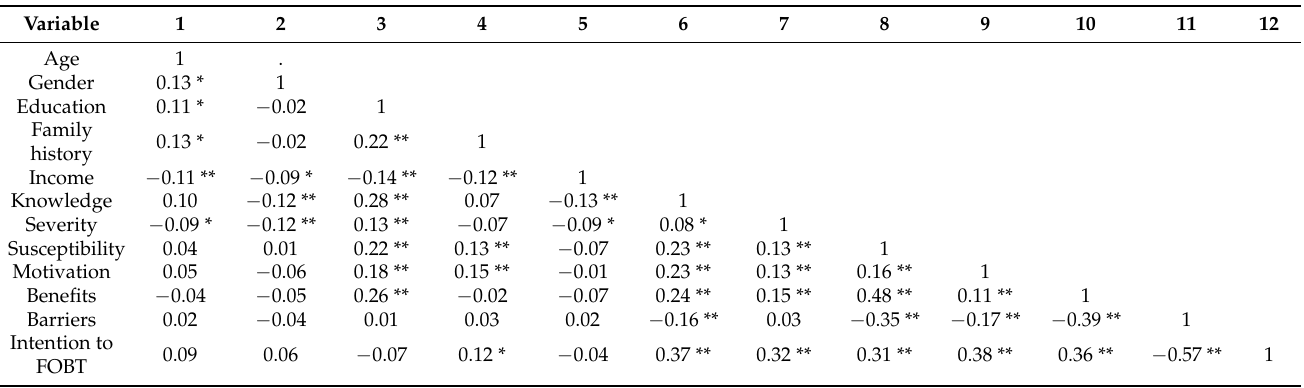
Table 3. Correlation matrix of main study variables (N =